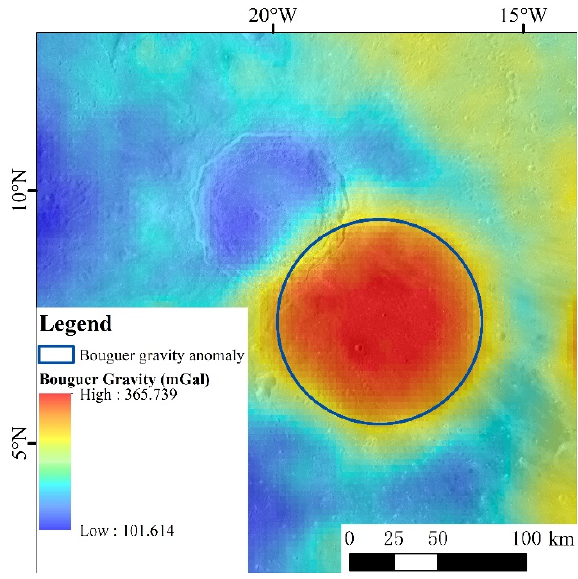
Figure 2. Bouguer gravity of the Copernicus area.